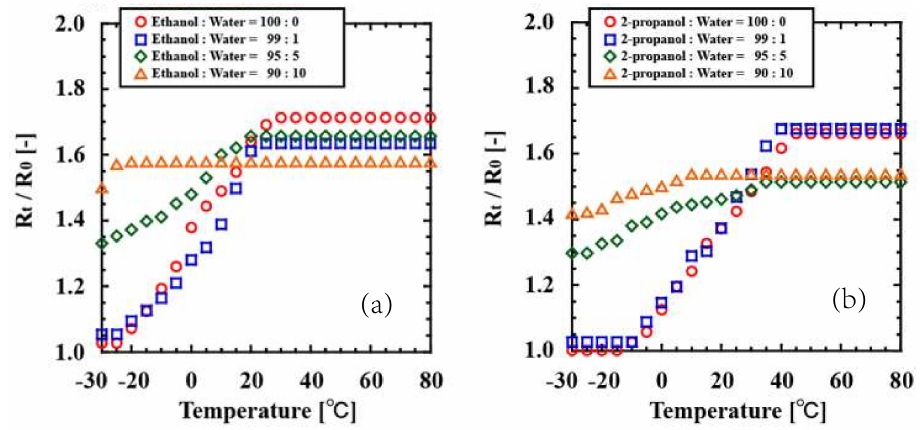
Figure 4. UCST behavior of the PTEGA gel in ( a ) hydrous ethanol and ( b ) hydrous 2-propanol.